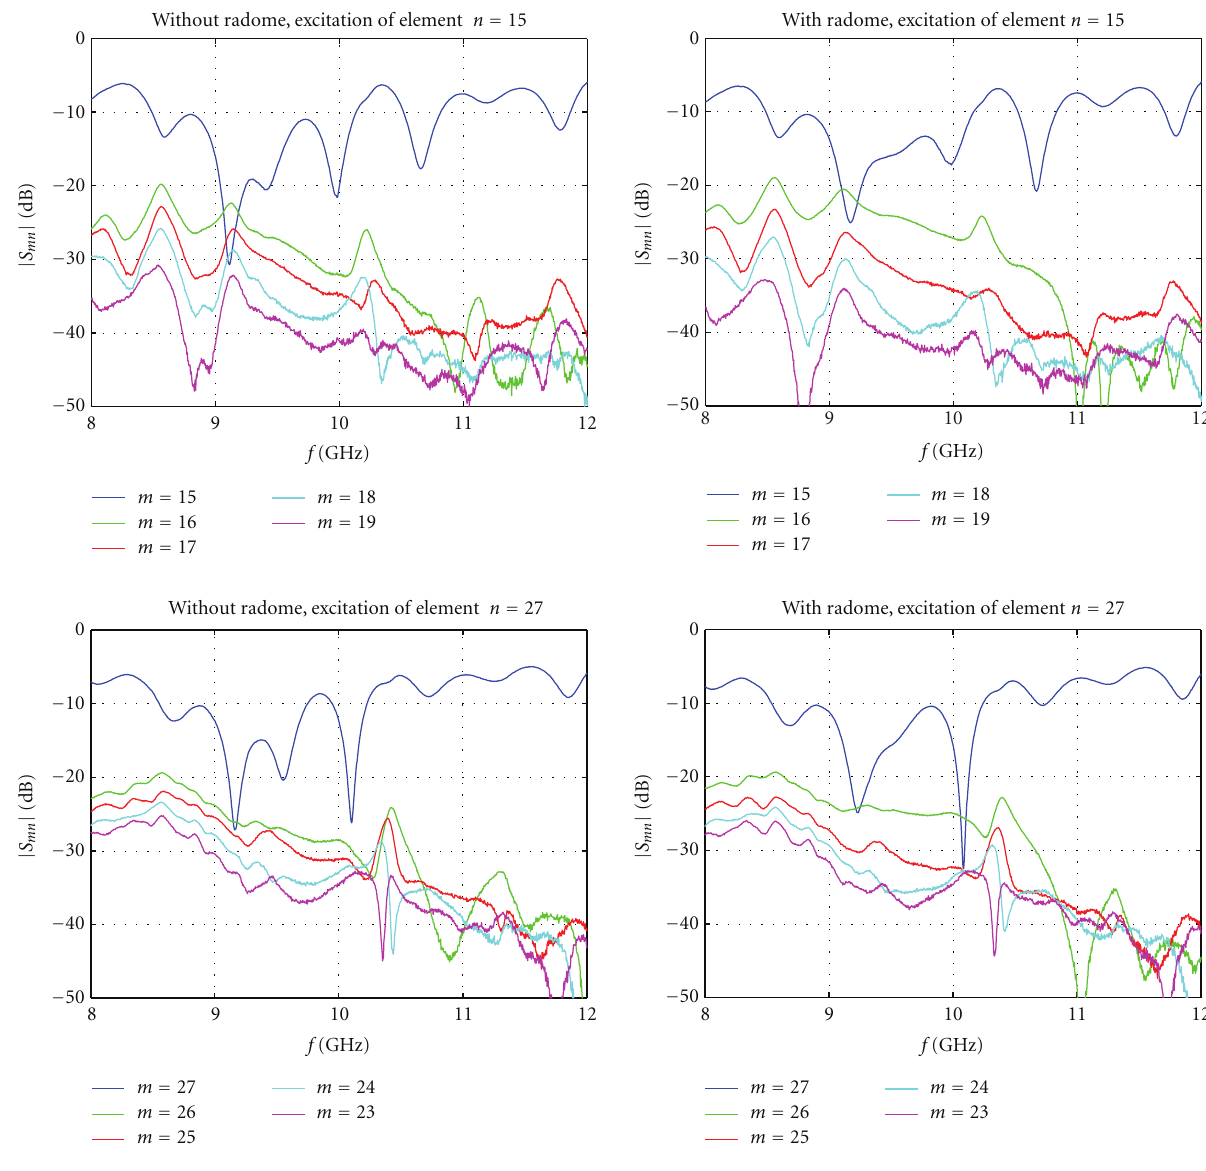
Figure 3: S -parameter measurement results for one of the centre elements (#15, top) and one of the side elements (#27, bottom) with (left) and without (right) radome (matching and mutual coupling to neighbouring